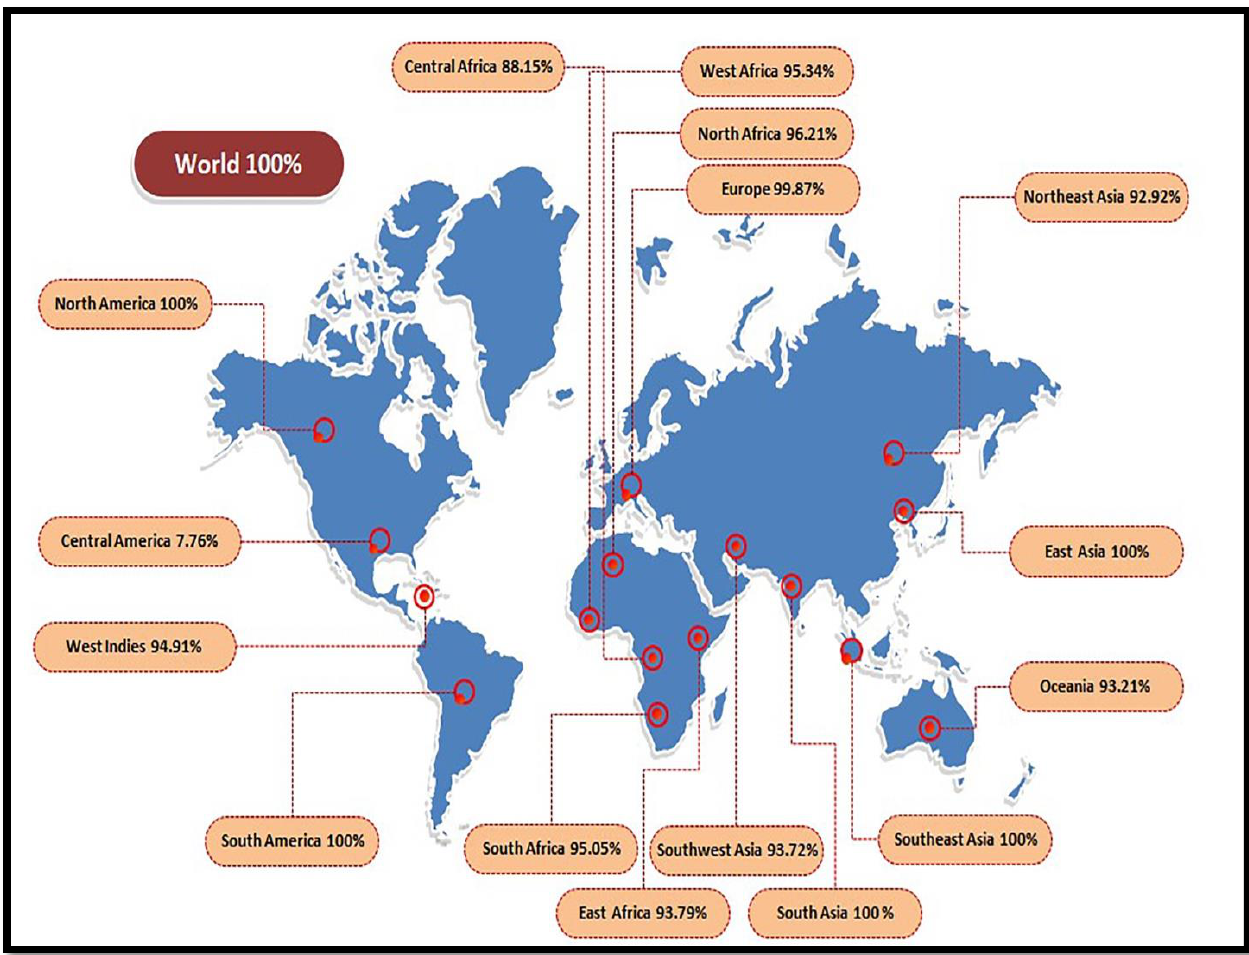
Figure 2. Population coverage analysis of alleles around the globe.